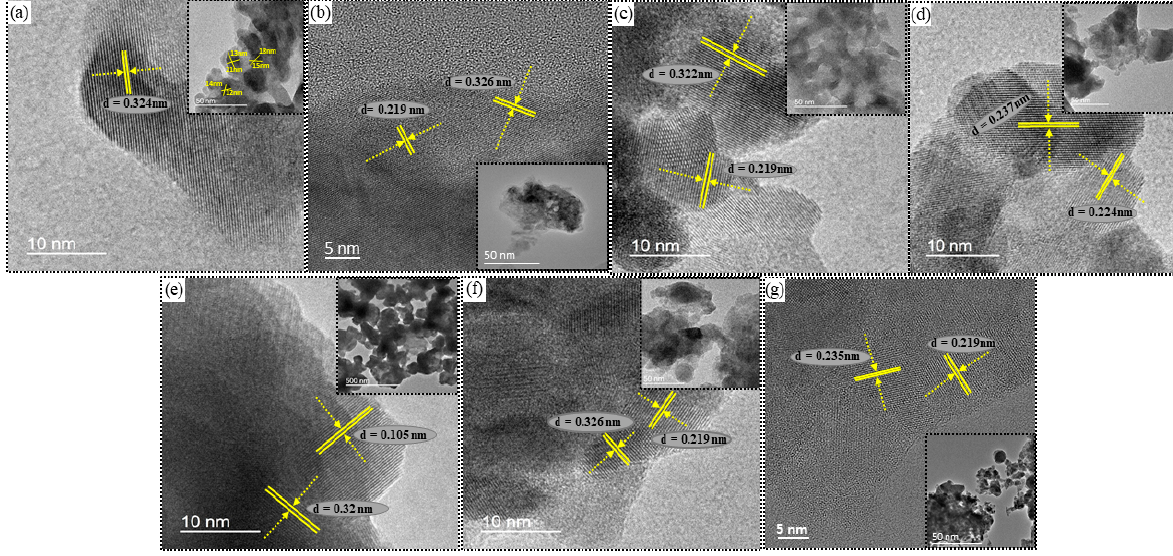
Figure 4. HR-TEM images for nano-powders of ( a ) Pure BT, ( b ) CeBTSn, ( c ) SmBTI, ( d ) SmCeBT, ( e ) SmCeBTSe, ( f ) GdBTI, and ( g ) SmGdBTI, (where inset area showed images at low-magnification).